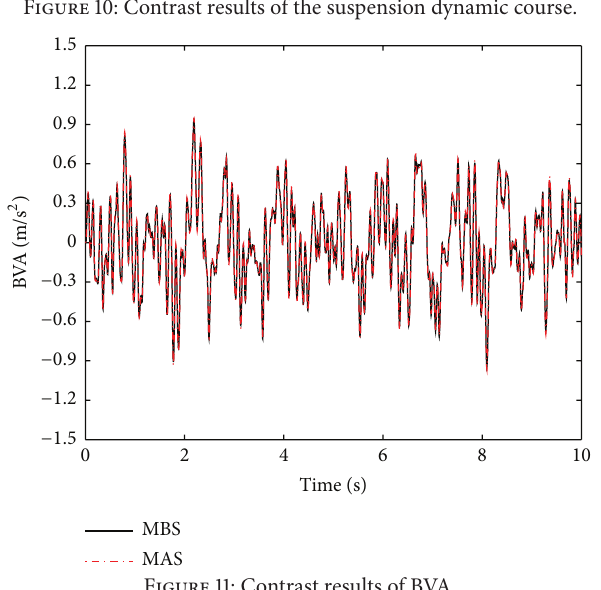
Figure 10: Contrast results of the suspension dynamic course.